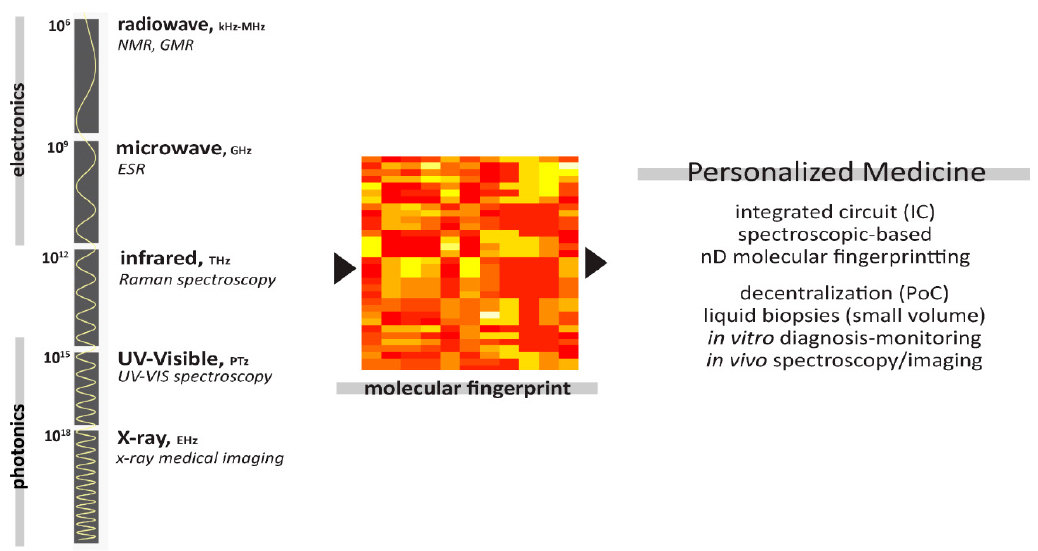
Figure 1. Electromagnetic spectrum with respect to the impedance spectroscopy used (e.g., nuclear magnetic resonance (NMR), electron spin resonance (ESR), and THz spectroscopy) to develop the next generation of integrated PoC spectroscopic-based technologies in personalized